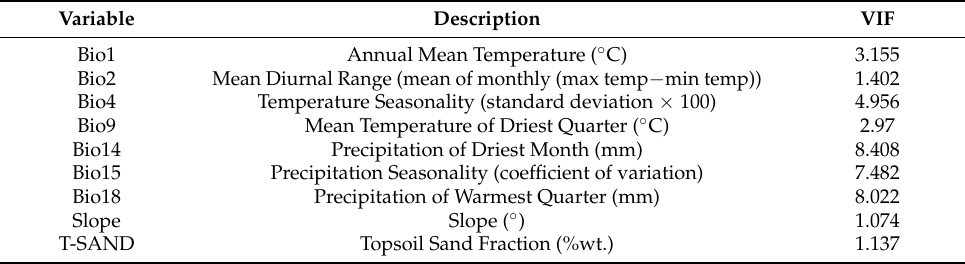
Table 1. VIF for each environmental